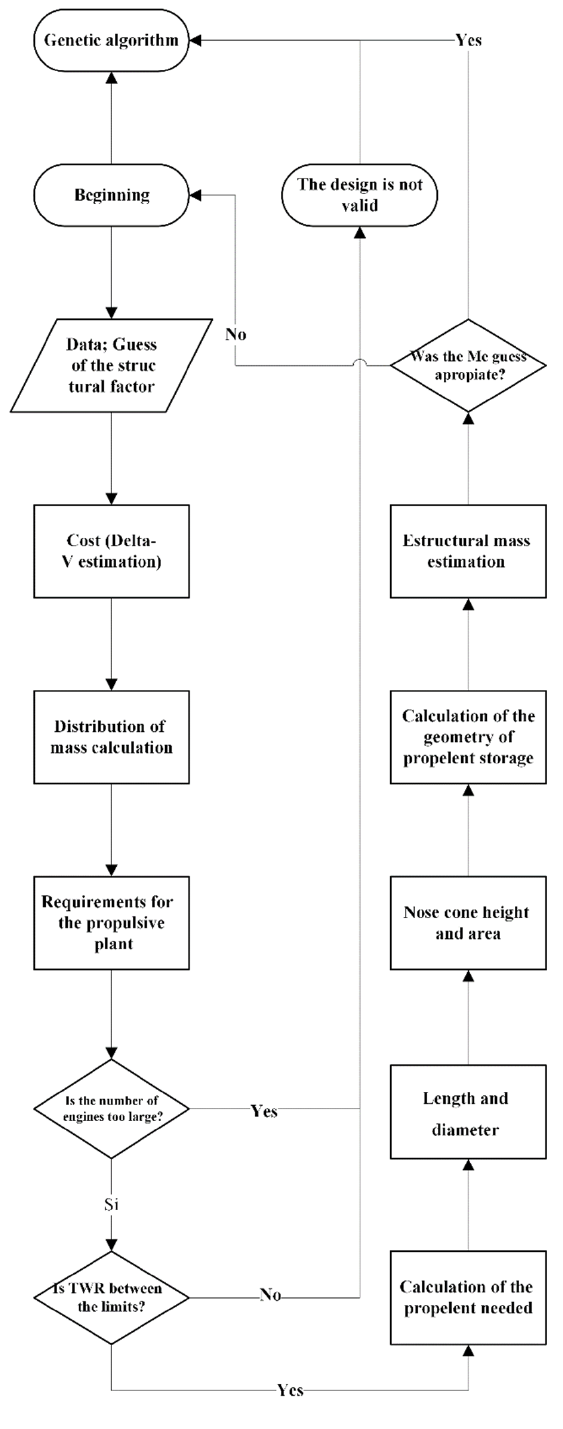
Figure 2. Design algorithm diagram.